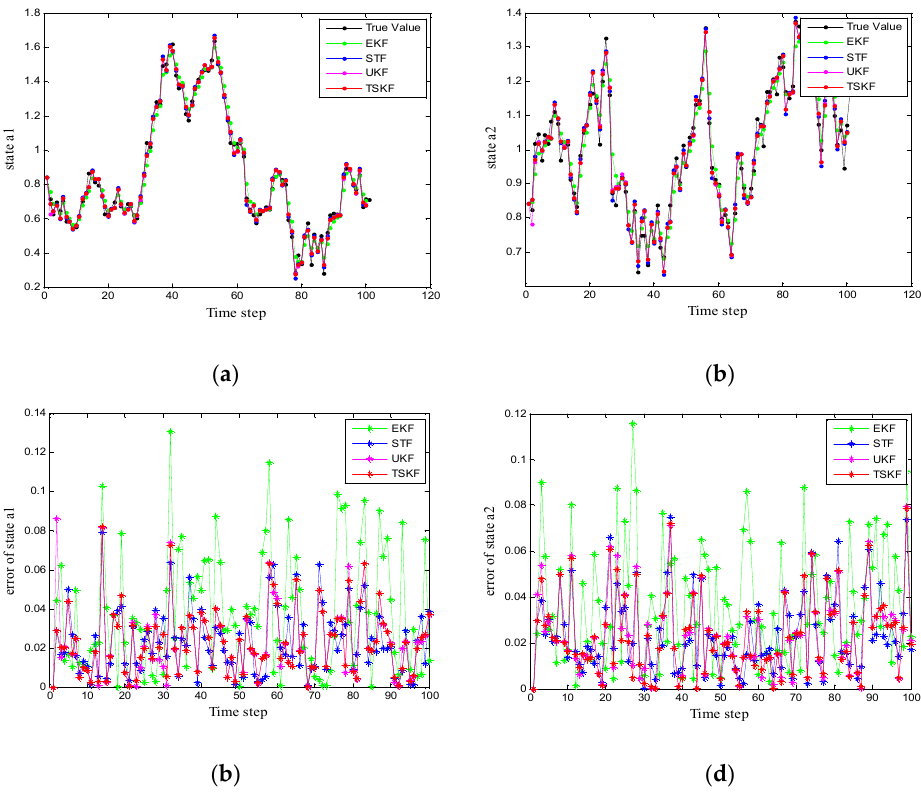
Figure 3. Filtering effect on parameter α : ( a ) true value and estimated value of α 1 , ( b ) true value and